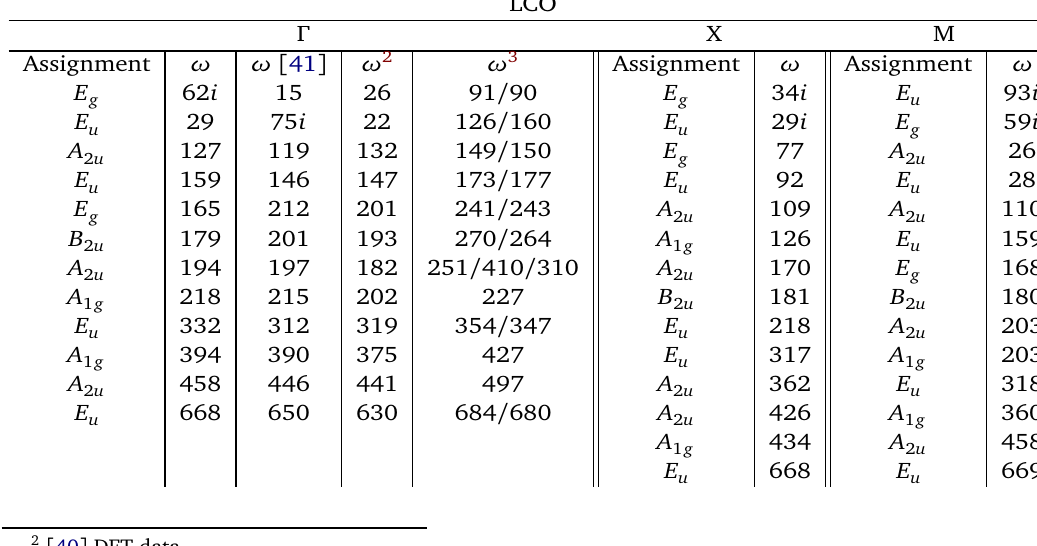
Table A1: LCO mode frequencies and assignments at Γ , X and M . All mode frequen- cies are in cm − 1